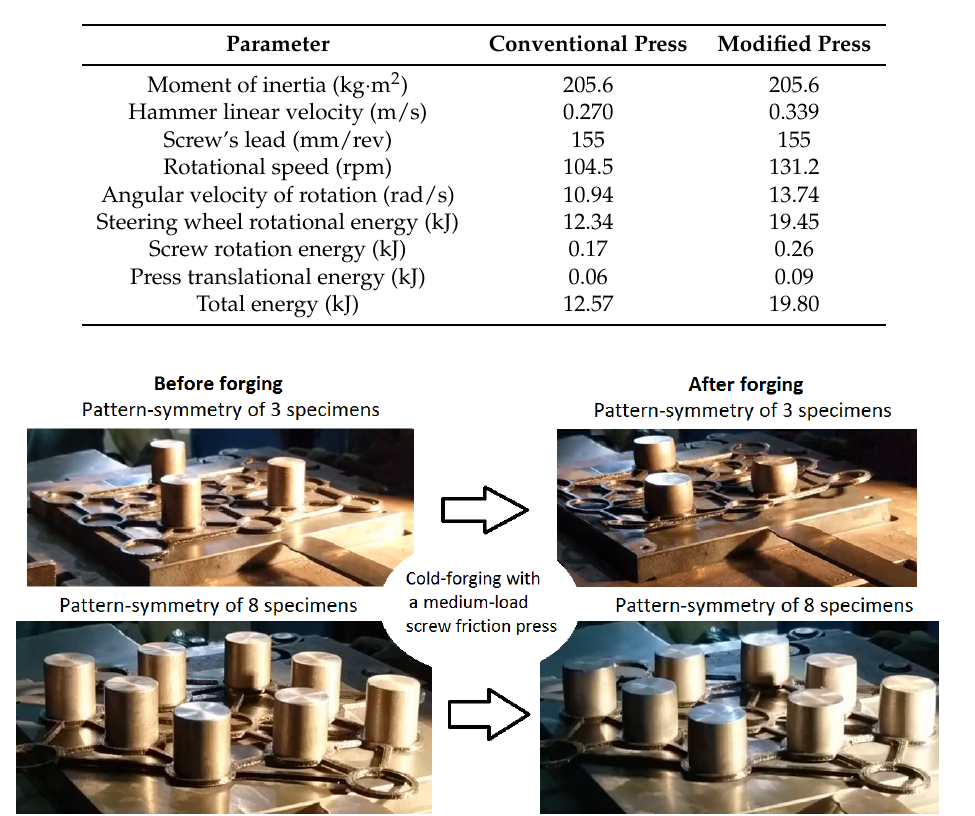
Table 3. Characteristic of the conventional and modified screw friction presses.